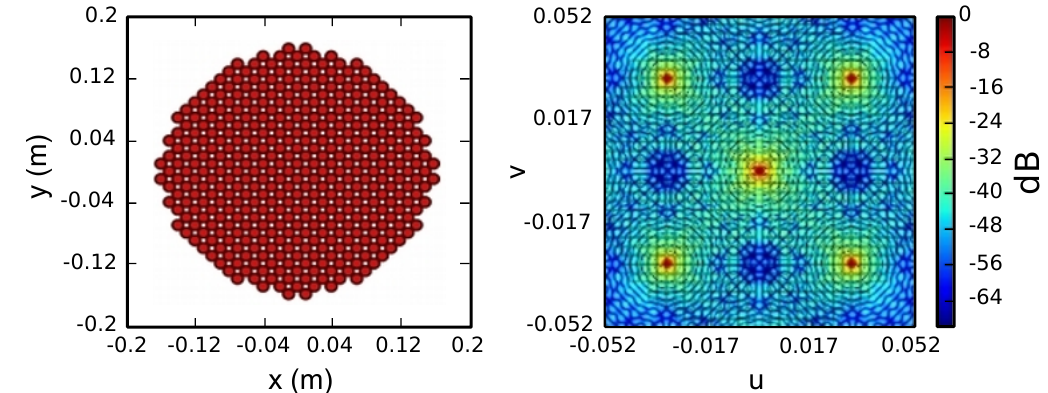
Figure 2. ( Left ) QUBIC aperture plane showing all 400 antennas open to the sky; ( right ) the interference pattern formed on each of the focal planes when the instrument is observing a point source located in the far field vertically along the instrument line-of-sight. The u and v coordinates are defined as: u = sin θ cos φ and v = sin θ sin φ , where θ and φ are the angles on the celestial sphere defining the synthetic